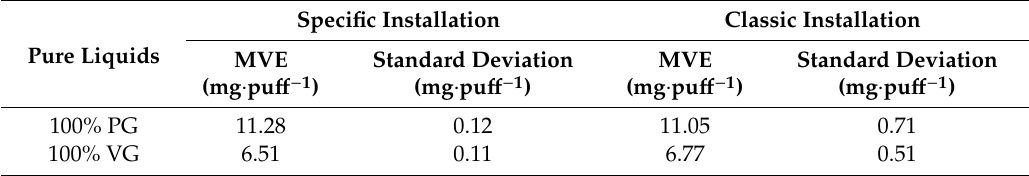
Table 4. MVE (mass of vaporized e-liquids) obtained with both installations at 15 W, the classical one (with traps) and the specific one (without trap) using pure PG and pure VG representing both extremities of the studied e-liquids’ density